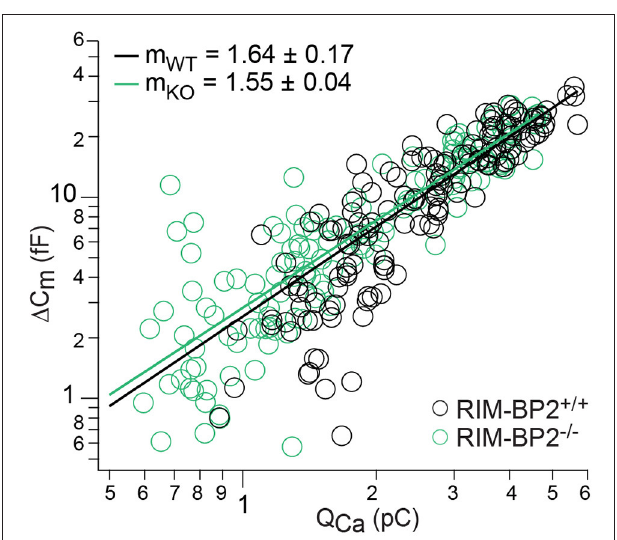
FIGURE 7 | RIM-BP2 disruption did not affect Ca 2 + -influx—exocytosis coupling. Double-logarithmic plot of exocytic membrane capacitance changes ( 1 C m ) and corresponding whole-cell Ca 2 + -current integrals (Q Ca ) during 20ms depolarizations and perfusion of IHCs with isradipine to gradually decrease the Ca 2 + -influx exocytosis. Symbols represent individual data points from RIM-BP2-deficient ( RIM-BP2 − / − , n = 7, each 20–43 data points, green) and control ( RIM-BP2 + / + , n = 6, each 20–42 data points, black) IHC depolarizations. Solid lines represent best fit power function [ 1 C m = A(Q Ca ) m ] to all data points of each genotype. The estimates of the apparent Ca 2 + -cooperativity m for each individual cell were statistically indistinguishable ( p = 0.5) between genotypes indicating normal Ca 2 + -influx—exocytosis coupling; Data information: Student’s t -test, n = number of IHCs; age of mice: